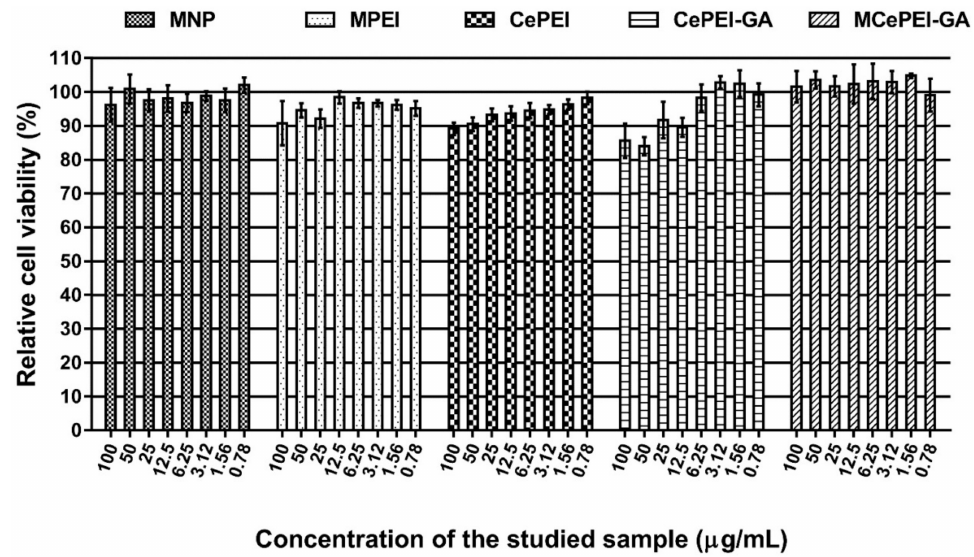
Figure8. In vitrocytotoxicityassayusingthe(3-(4,5-dimethylthiazol-2-yl)-5-(3-carboxymethoxy-phenyl) -2-(4-sulfophenyl)-2H-tetrazolium) (MTS) method for MNP, MPEI, CePEI, CePEI-GA and MCePEI-GA